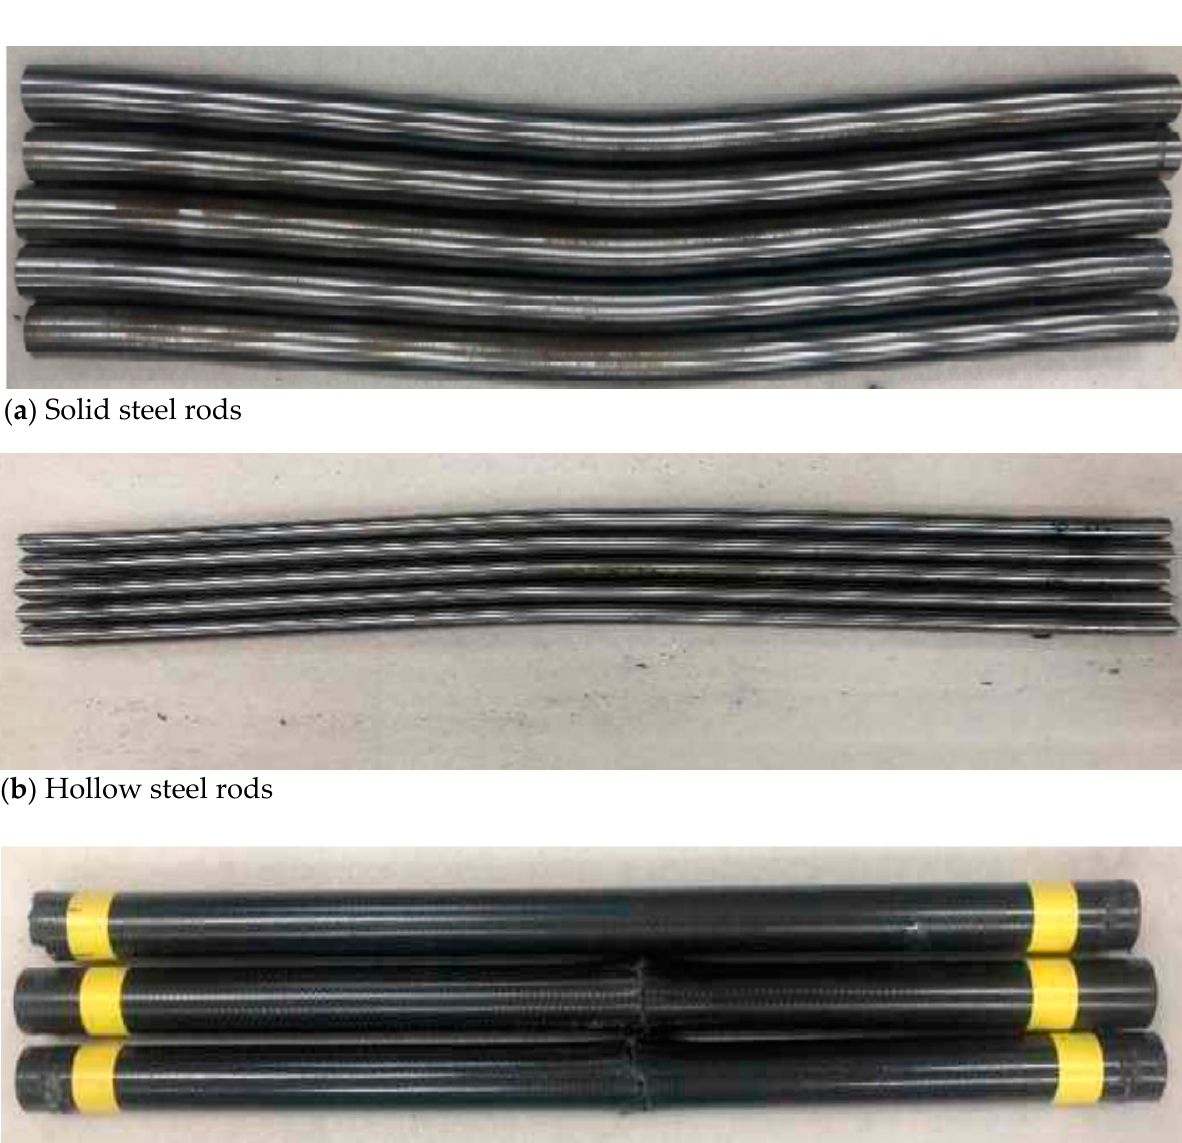
Figure 7. Experimental analysis of the test sample.